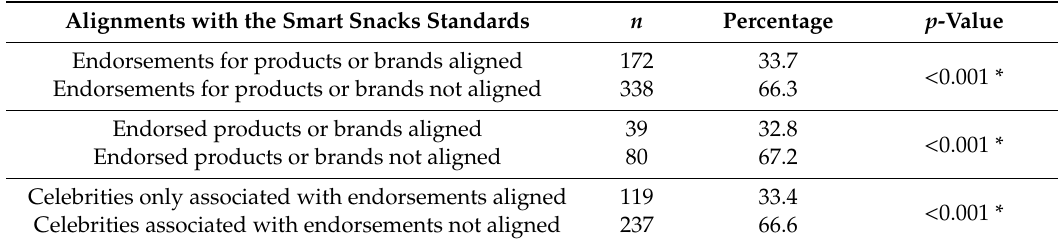
Table 5. Alignments with the USDA’s Smart Snacks Standards [13] for the food and beverage endorsements ( n = 510), brands ( n = 119) and celebrities ( n = 356). Alignments with the Smart Snacks